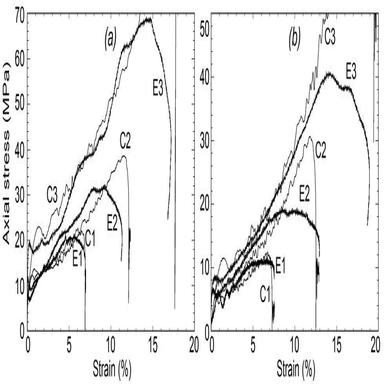
The calculated stress-strain response with fitted compaction kinetic compared with the experiments for the fine silica sand: as-received, ρ0 = 1.605(1), 1.57 (2), 1.615(3) g/cm3 (a) and moisturised, ρ0 = 1.665(1), 1.64(2), 1.63(3) g/cm3 (b), where 1, 2 and 3 correspond to different strain rates.